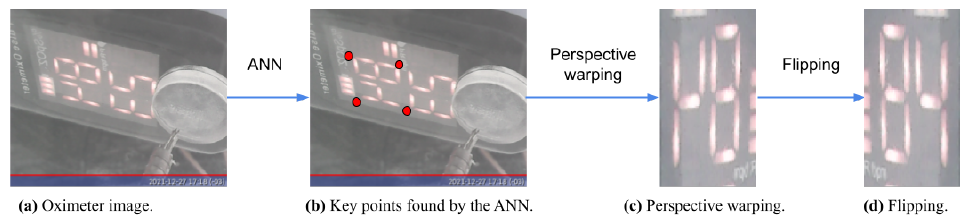
Figure 6. Processing steps for the oximeter display images. ( a ) The oximeter image taken by the camera; ( b ) the ANN output points marked in red; ( c ) the resulting warping procedure given the VGG16 points; ( d ) flipping the image to generate the final image.